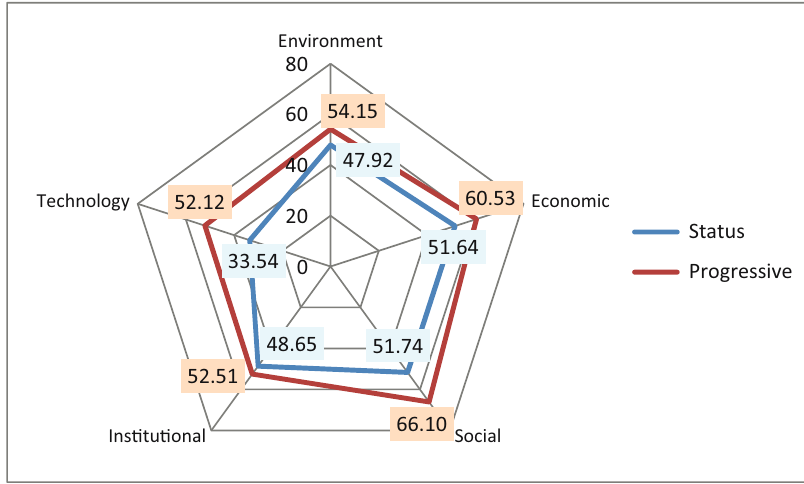
Figure 8: Kite diagram of sustainability and progressive